Question: What kind of plot is shown here?
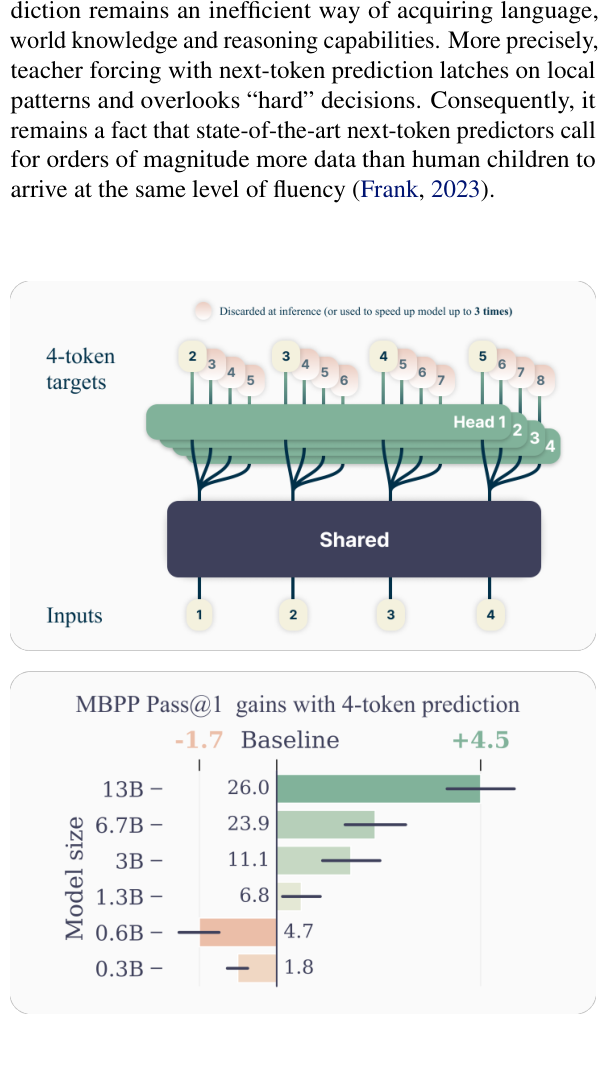
Answer: bar